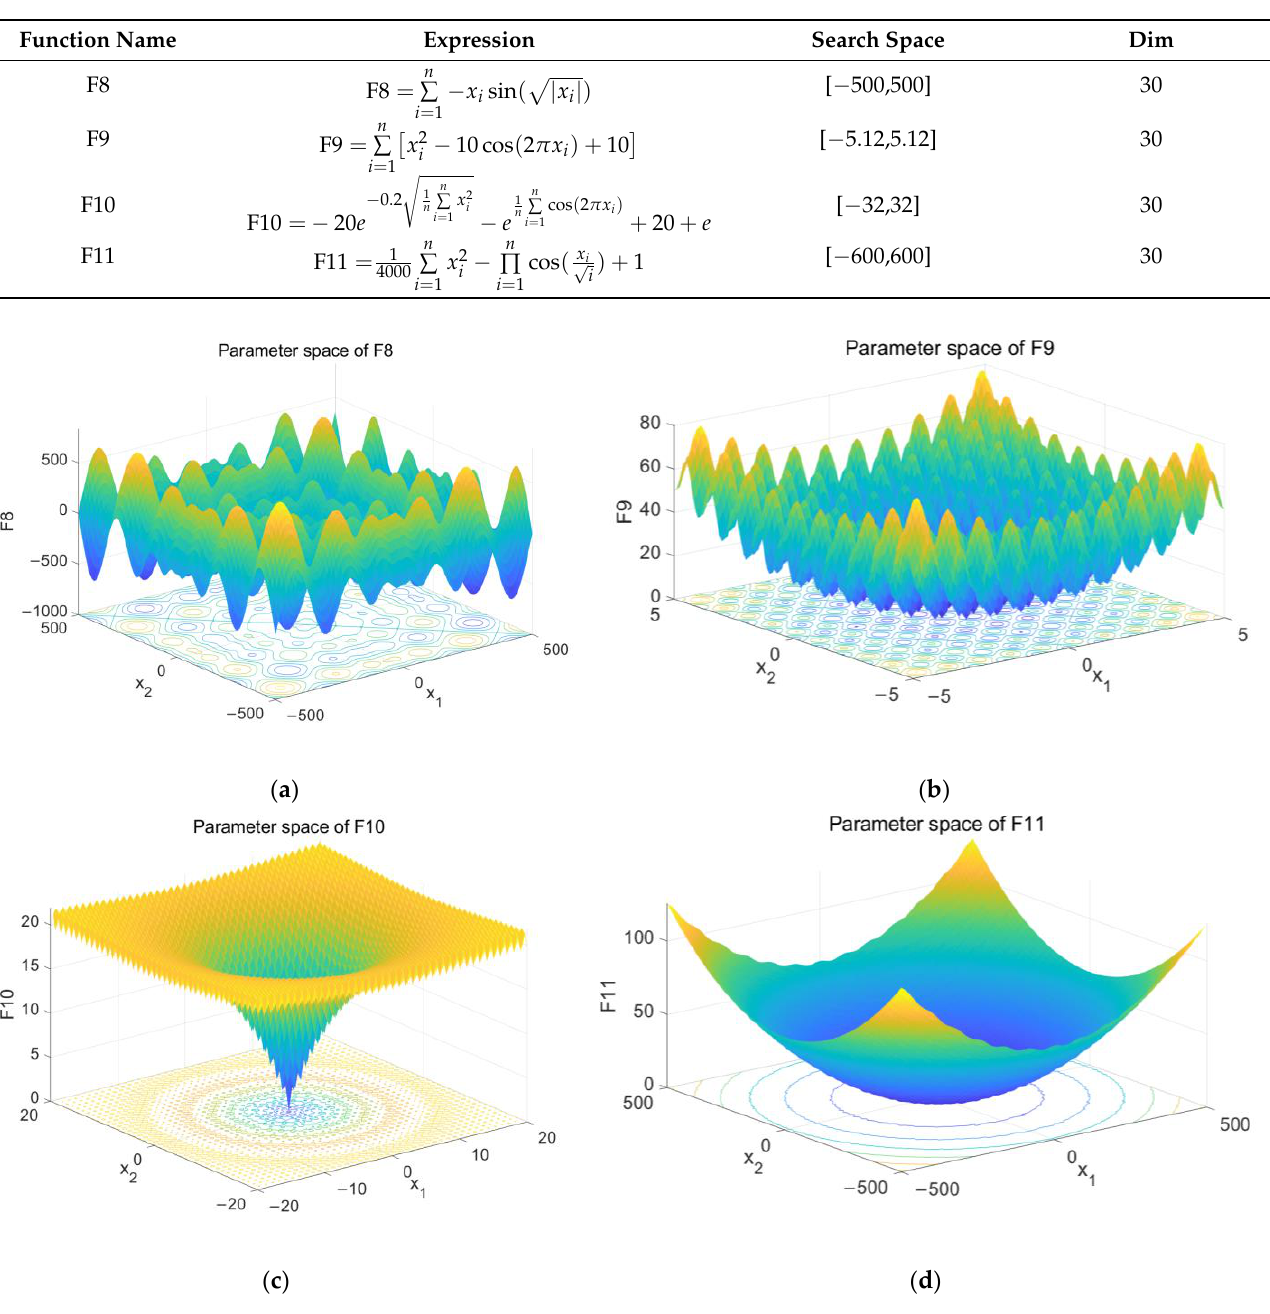
Figure 7. The results of parameter space. ( a ) The parameter space of F8 and ( b ) the parameter space